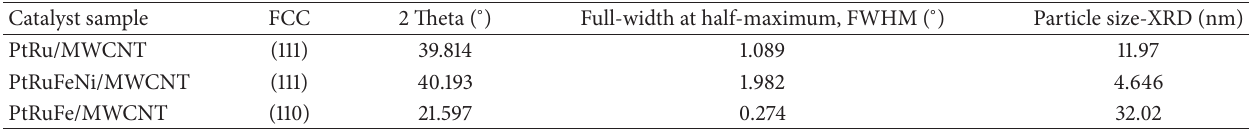
Table 1: Particle sizes calculated from the XRD results.